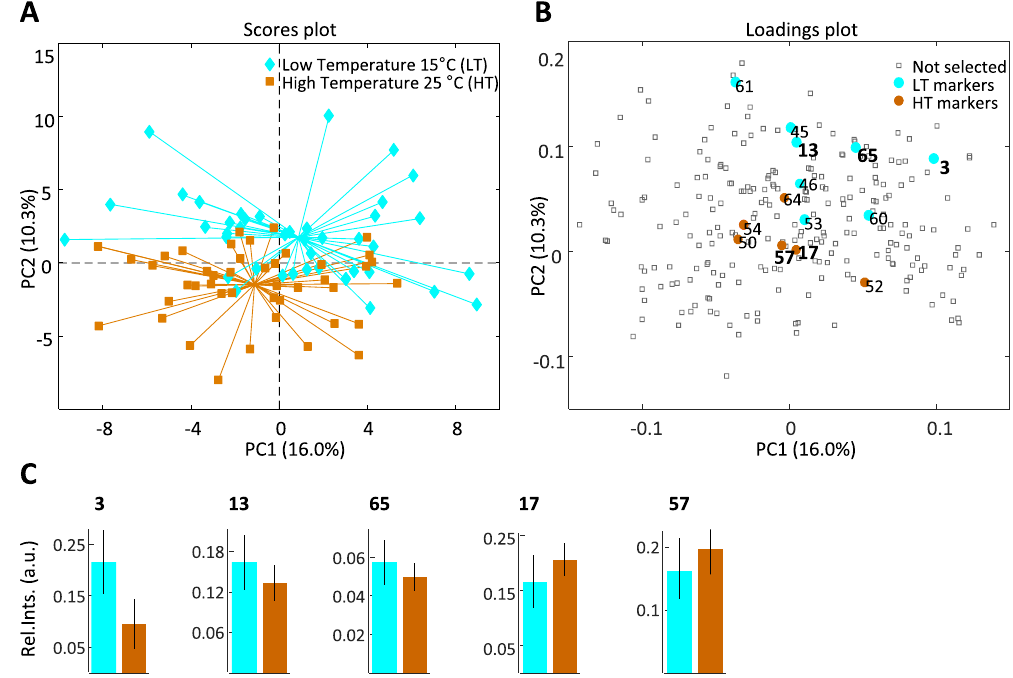
Figure 3. Principal component analysis (PCA) of the ANOVA-simultaneous component analysis (ASCA)- based growth temperature effect separated matrix, X TEMP . ( A ) Scores plot of the PCA model developed on X TEMP . ( B ) Loadings plot of the same PCA model. Metabolite markers for the temperature effect were selected from the PLS-DA models using a variable selection approach. ( C ) Relative mean concentrations of some metabolite markers, calculated from the raw data, for the low growth temperature (15 °C) (3: hepta-2,4-dienoic acid, methyl ester, 13: benzoic acid, 65: 3-hydroxybenzoic acid) and the high growth temperature (25 °C) (17: glycerol, 57: p-hydroxyphenylactic acid, methyl